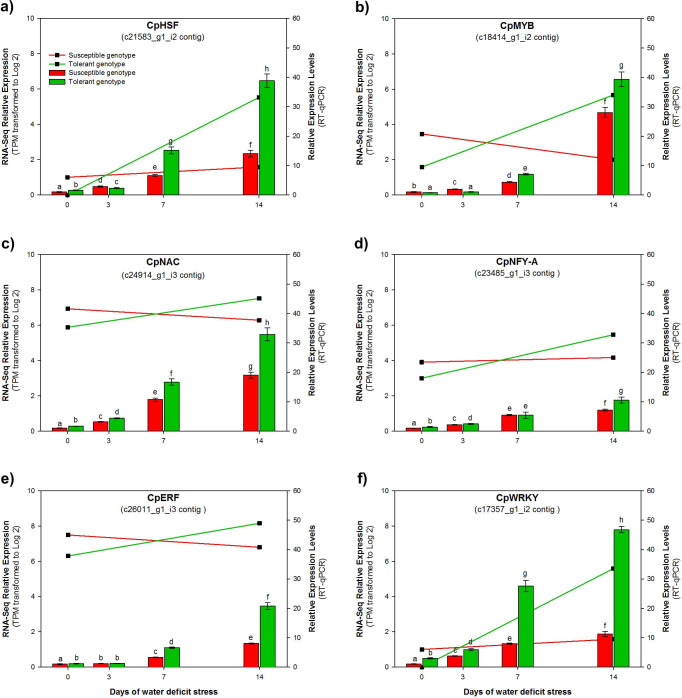
Expression levels of six selected TF candidate genes from leaves of the two C. papaya genotypes when well-irrigated (day 0), or when exposed to 14 d.p.t. of WDS.Red (S) and green (T) lines represent the expression level of transcripts per million (TPM) of the following 6 TF genes: CpHSF a), CpMYB b), CpNAC c), CpNFY-A d), CpERF e) and CpWRKY f). In the case of TPM data were transformed to Log 2 values. The red (S) and green (T) bars represent the Relative Expression Levels (REL) of the same genes determined by RT-qPCR, after 3, 7 and 14 of WDS. REL data are the means ± SD of three biological replicates. Different letters indicate significant differences.